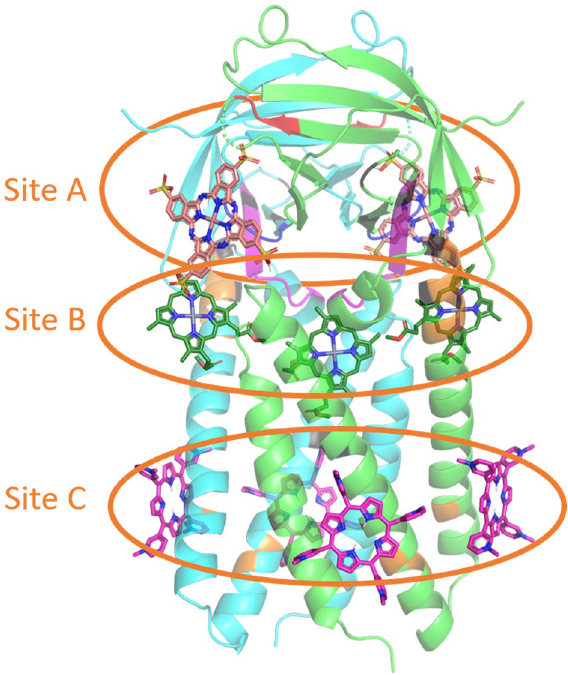
Figure 2. The complexes of MHCs with dimer of ORF3a. TMPyP3—magenta, ZNDP—green, NPcSO3Cu— pink. Domain structure in accordance with 22 painted in colors: domain III—orange, domain IV—violet, domain V—dark blue, domain